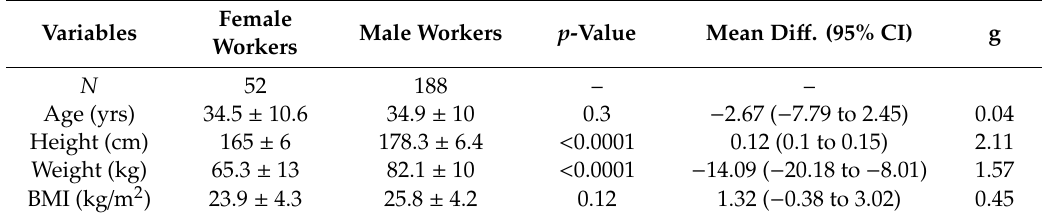
Table 1. Anthropometric data of subjects by